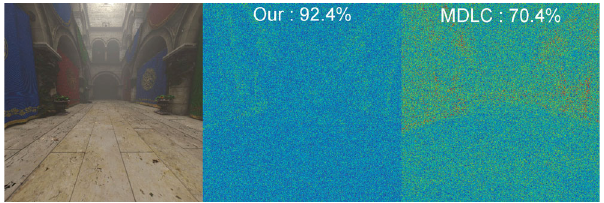
Fig. 6 Sponza scene with participating media.